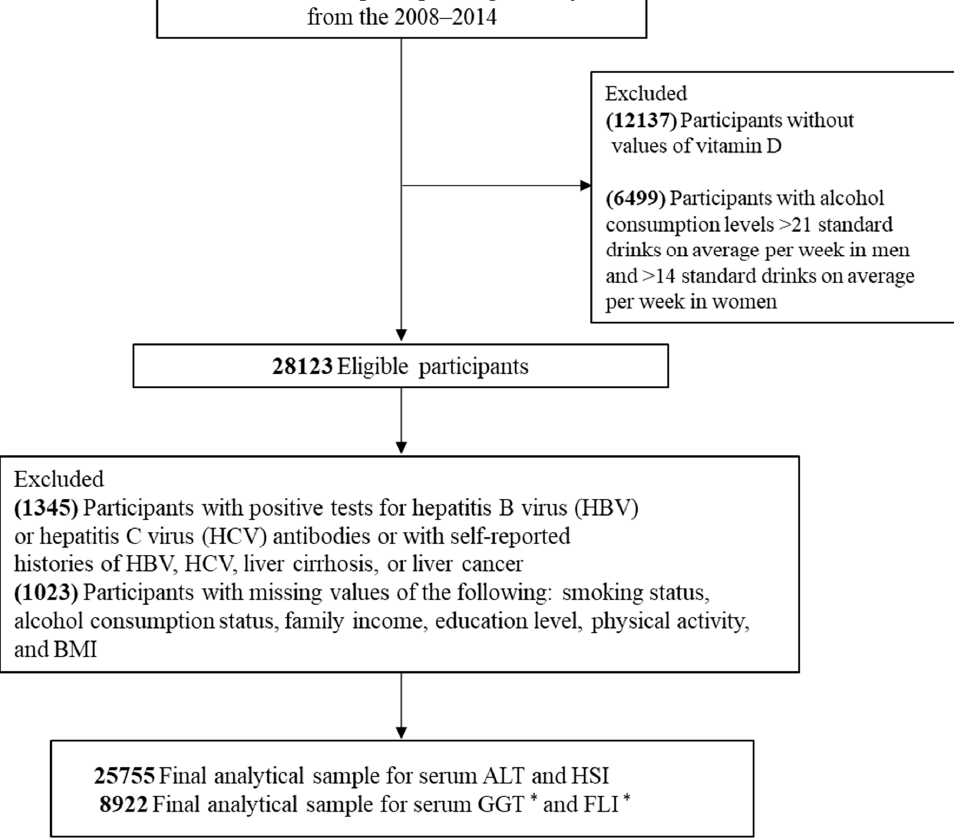
Figure 1. Flow diagram showing study sample derivation. KNHANES: Korea National Health and Nutrition Examination Survey, BMI: body mass index, ALT: alanine aminotransferase, HSI: hepatic steatosis index, GGT: serum gamma-glutamyl transferase, FLI: fatty liver index. * Information on data for GGT and FLI is presented separately, hence serum GGT was measured only in 2010~2011.